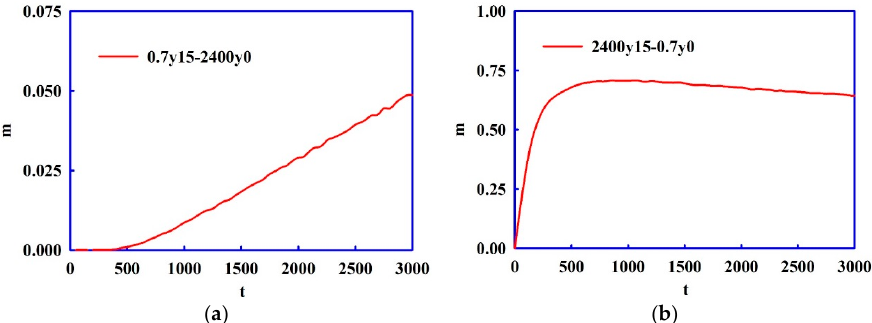
Figure 11. Normalized mixing efficiency m for mixing between two puffs released at the channel wall, and at y = 15, but with Schmidt numbers switching between the two configurations (( a ): mixing between puff 0.7y15 and puff 2400y0, ( b ): mixing between puff 2400y15 and puff 0.7y0).